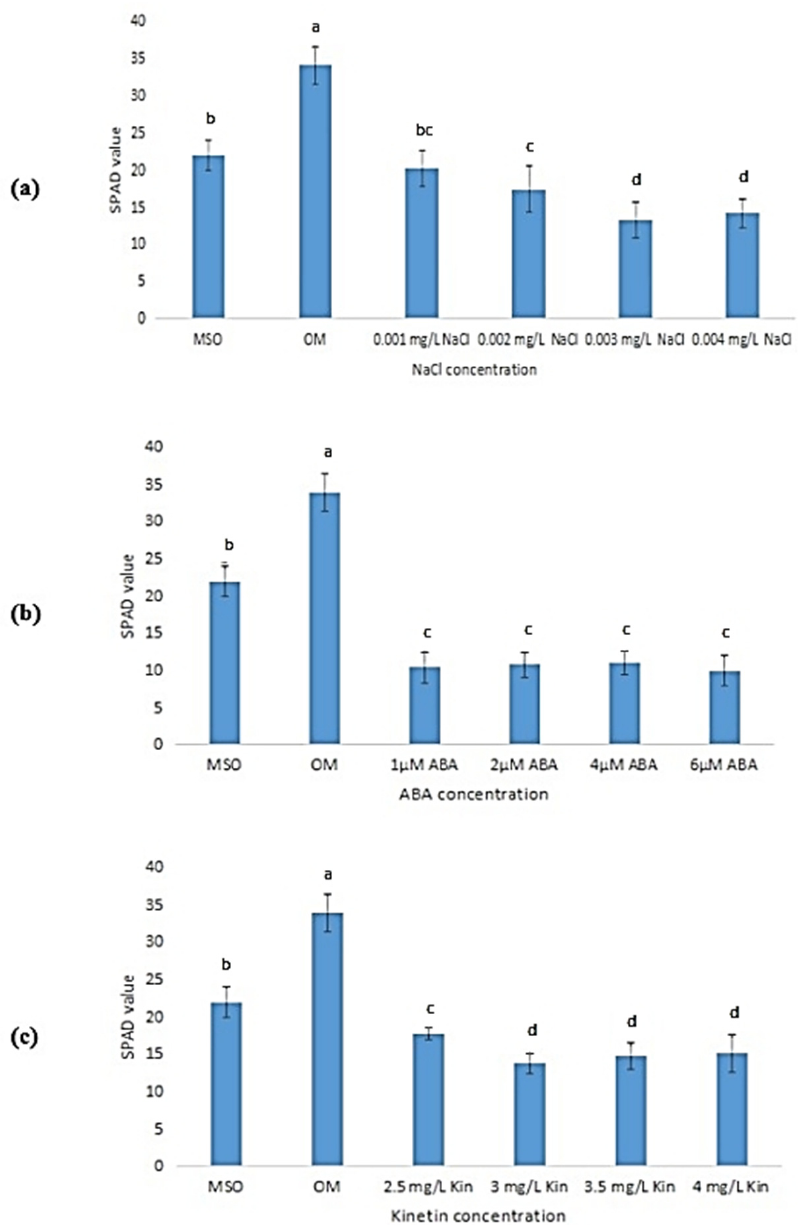
Figure 8. SPAD values in plants exposed to: ( a ) salt stress; ( b ) ABA; ( c ) high kinetin levels. Means with different letters are significantly different at p < 0.05 according to Duncan’s multiple range test (DMRT).